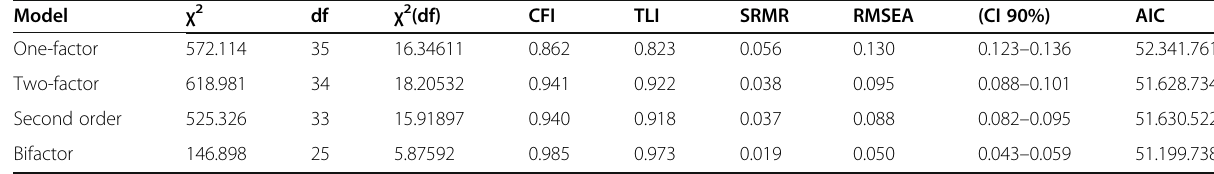
Table 1 Confirmatory factor analysis goodness-of-fit indices for the different K10 models evaluated Model